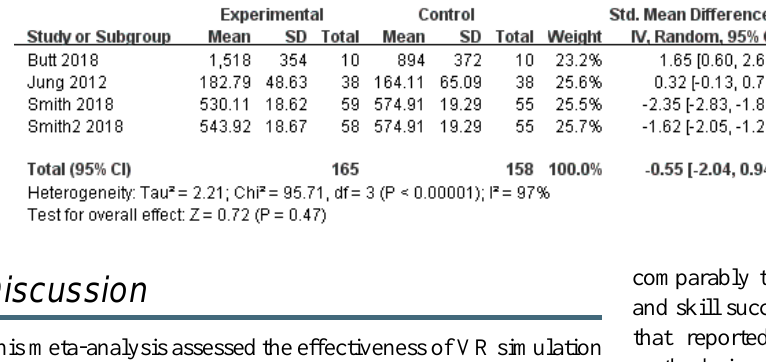
Figure 8. Forest plot of virtual reality on performance